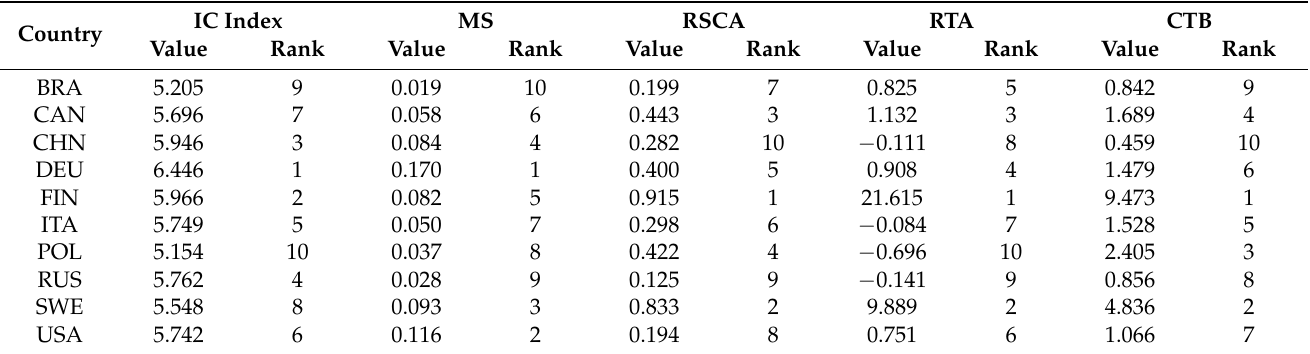
Table 11. The results of MS, RSCA, RTA and CTB for 2021 wood-based